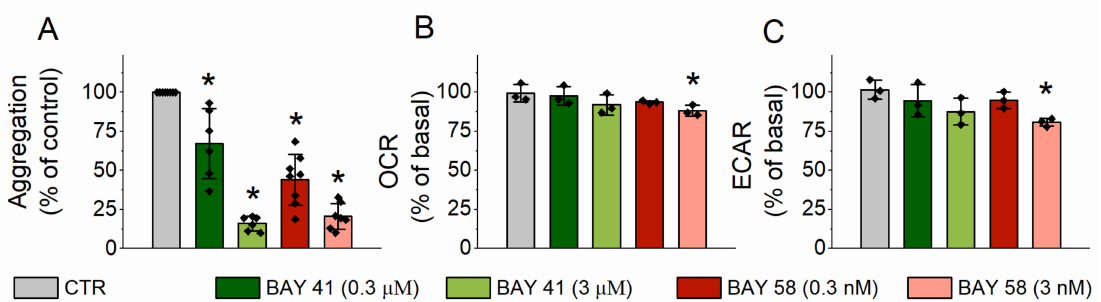
Figure 3. The effects of soluble guanylate cyclase (sGC) activation on platelet aggregation and energy metabolism. Platelets treated with DMSO (as a vehicle; 0.1%), BAY 41-2272 (0.3 or 3 µ M) or BAY 58-2667 (0.3 or 3 nM). ( A ) Aggregation of platelets activated with collagen (2 ug/mL), ( B ) changes in oxygen consumption rate (OCR; 30 min after addition of tested compounds) presented as % of basal OCR and ( C ) changes in oxygen consumption rate (OCR; 30 min after addition of tested compounds) presented as % of basal. Data represent means +/-SD from et least three independent experiments. * p < 0.05 as compared with the CTR